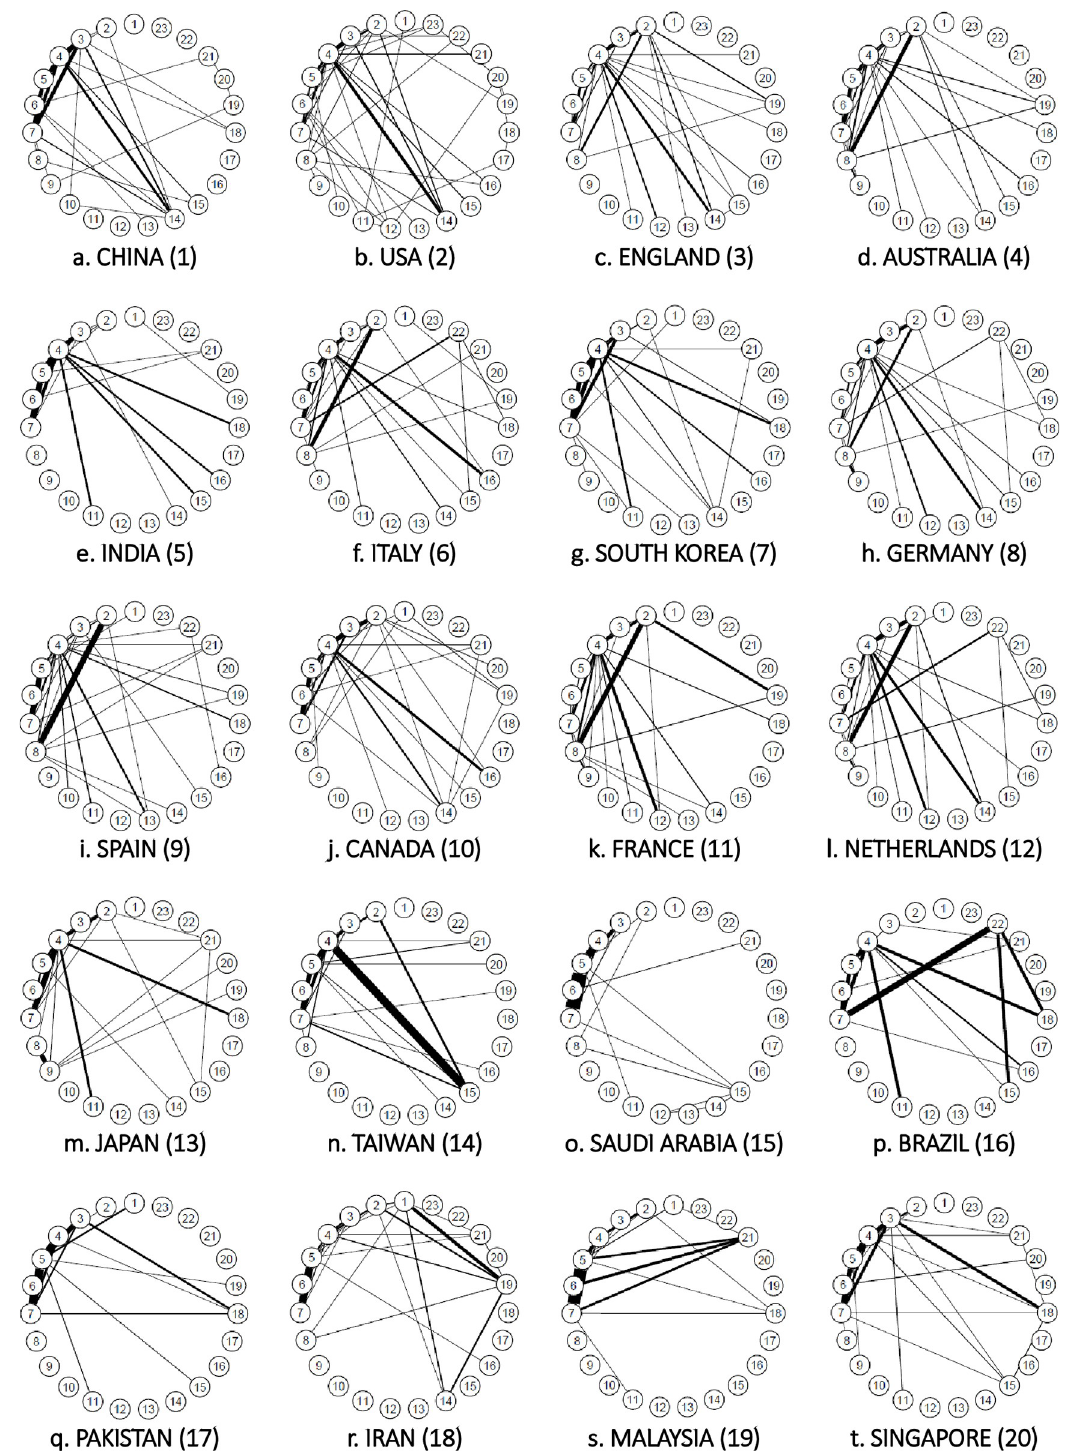
Fig 11. Connections between author research fields in the top 20 big data countries (2018). Note . This indicates connections with a strength of 1.0% or more.